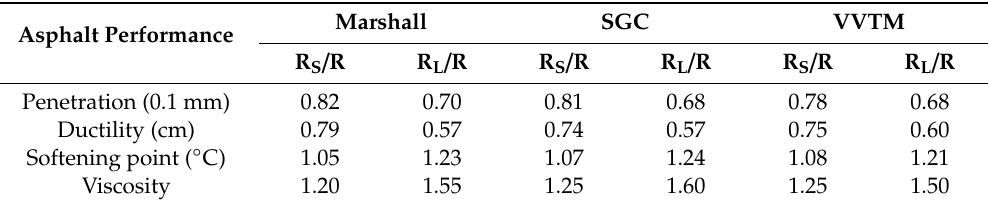
Table15. ComparisonofagingperformancesofSMA-13asphaltmixturesdesignedbydi ff erentmethods. Asphalt Performance